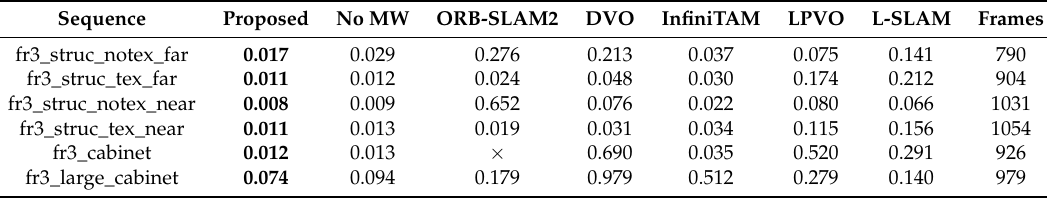
Figure 8. Results of camera poses and landmarks estimated by our proposed method on the TUM RGB-D dataset: ( a ) ‘fr3_cabinet’; ( b ) ‘fr3_struc_notex_far’; ( c ) ‘fr3_struc_notex_near’; ( d ) ‘fr3_large_cabinet’. For each sequence, four images from left to right represent, respectively, one color image in the current sequence, the point landmarks (black dots) obtained by our proposed method, the plane landmarks obtained by our proposed method, and the trajectory comparison between the ground truth and our proposed method. The estimated keyframe trace (blue boxes) and connection graph between them (green lines) were added to the middle images that show point and plane landmarks. Table 2. Comparison of ATE.RMSE (unit: m) on the TUM RGB-D Dataset. The smallest values are bolded, which indicates the most accurate method for the pose estimation.